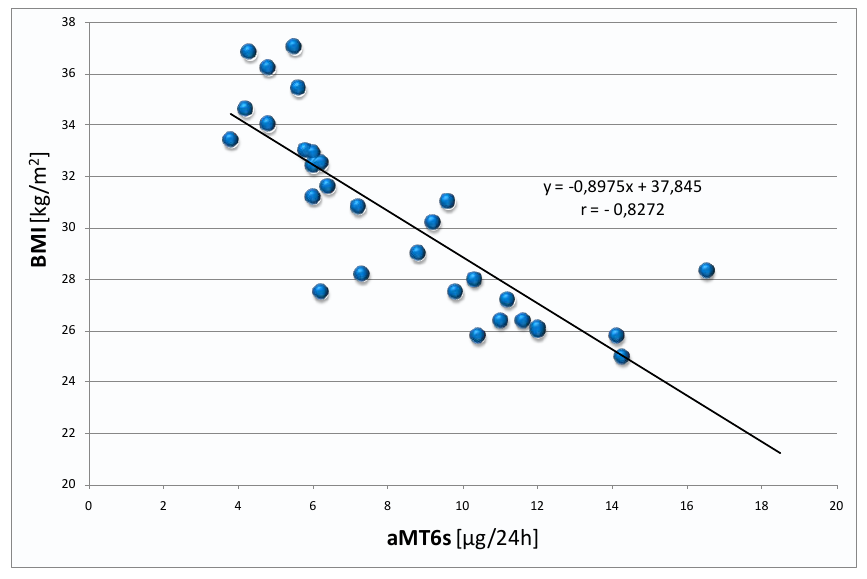
Figure 5. Correlation between urinary 6-sulphatoxymelatonin levels and body mass index (BMI) in the group of overweight women (group III).